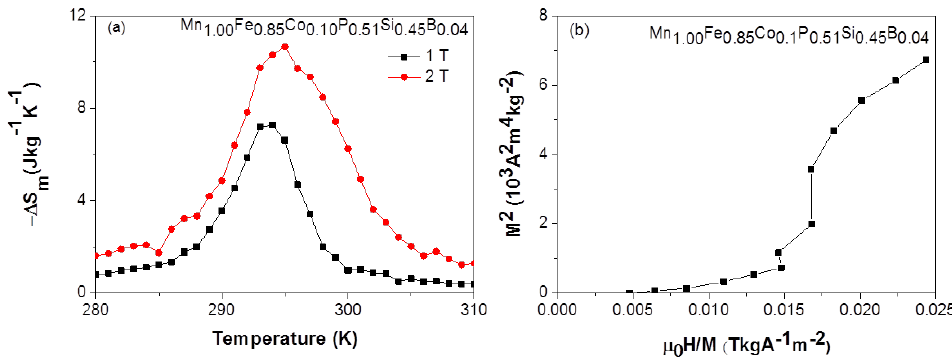
Figure 5. ( a ) Magnetic entropy change ( ∆ S m ) as a function of temperature for a field change of 1 T ( black markers) and 2 T ( red markers); ( b ) Arrot plots derived from isofield M B (T) curves measured upon cooling in the vicinity of T C for the Mn 1.00 Fe 0.85 Co 0.10 P 0.51 Si 0.45 B 0.04 compound.